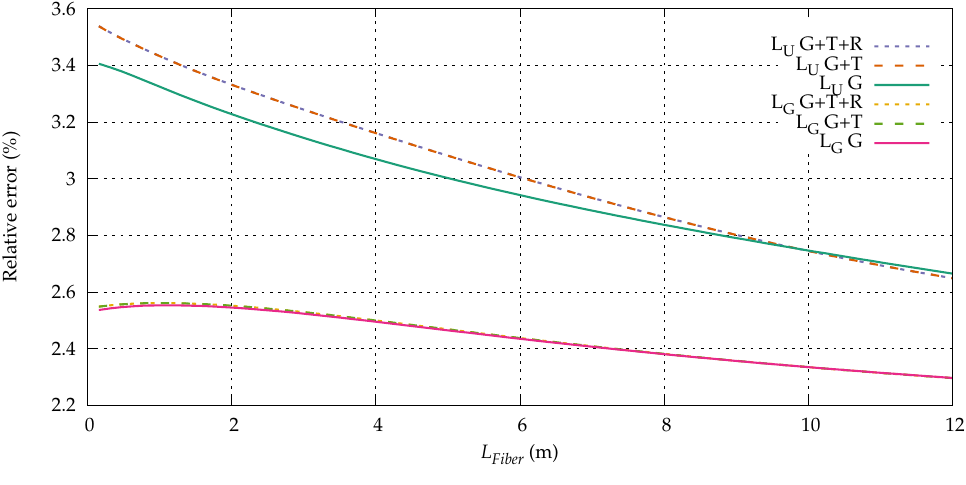
Figure 14. Simulated relative error considering the